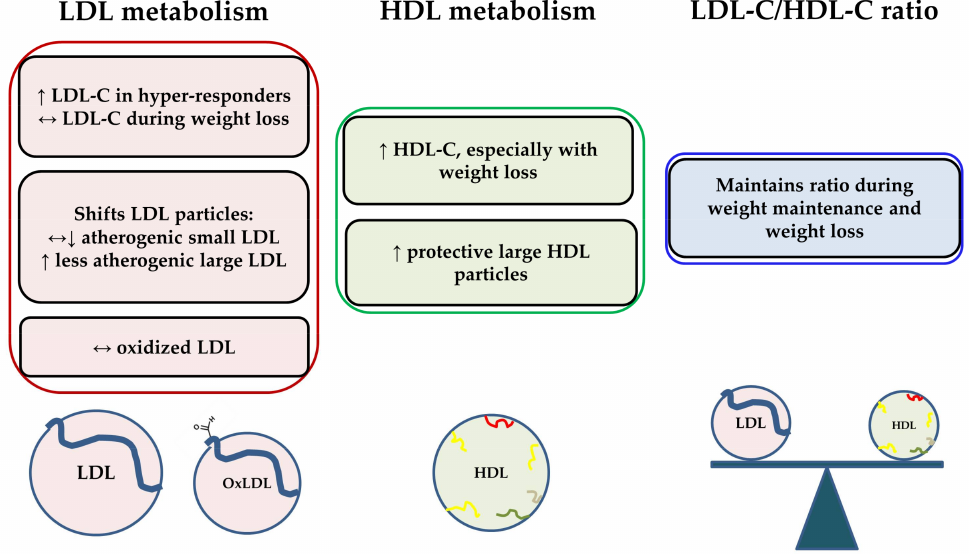
Figure 1. Summary of effects of consuming additional cholesterol from eggs on LDL and HDL metabolism in recent clinical studies. OxLDL = oxidized LDL; ↔ = no change relative to control, ↑ = increase relative to control; ↓ = decrease relative to